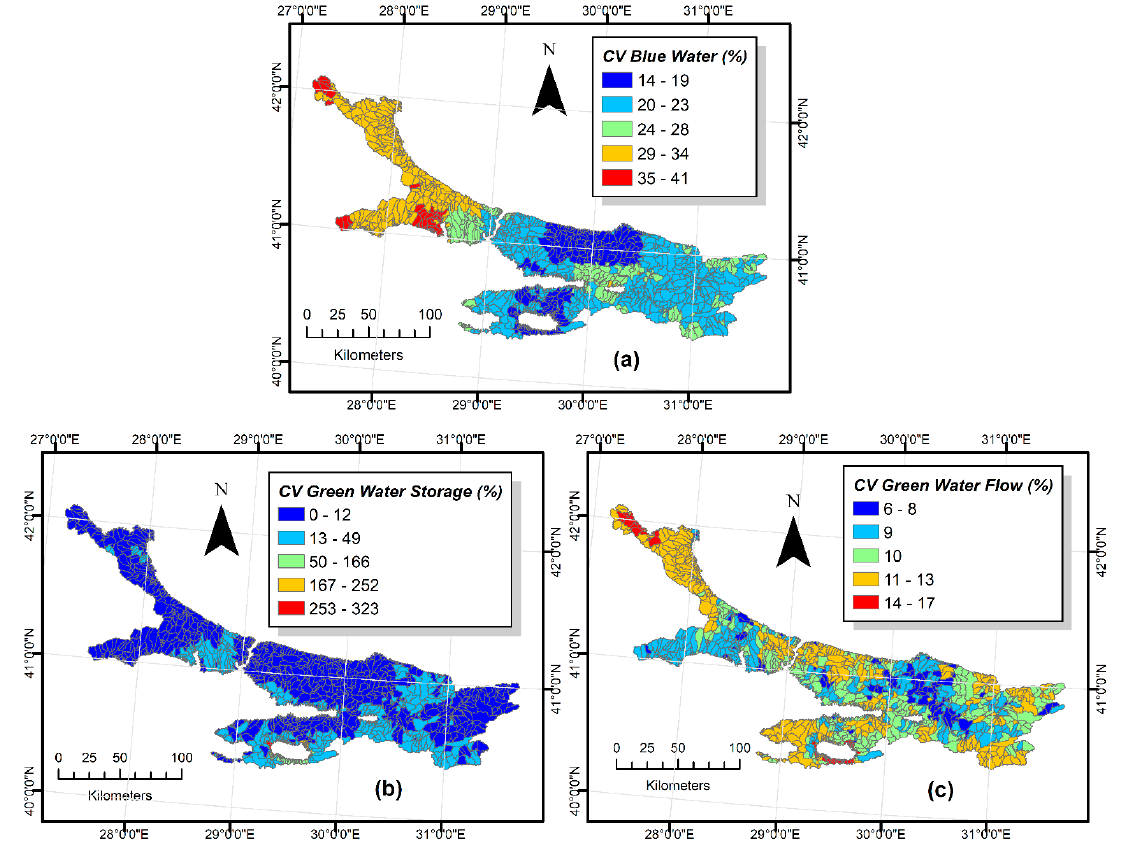
Figure 10. Coefficient of variation (CV) of the modelled annual (1980–2013) ( a ) blue-water resources; ( b ) green-water flow and ( c ) green-water storage.